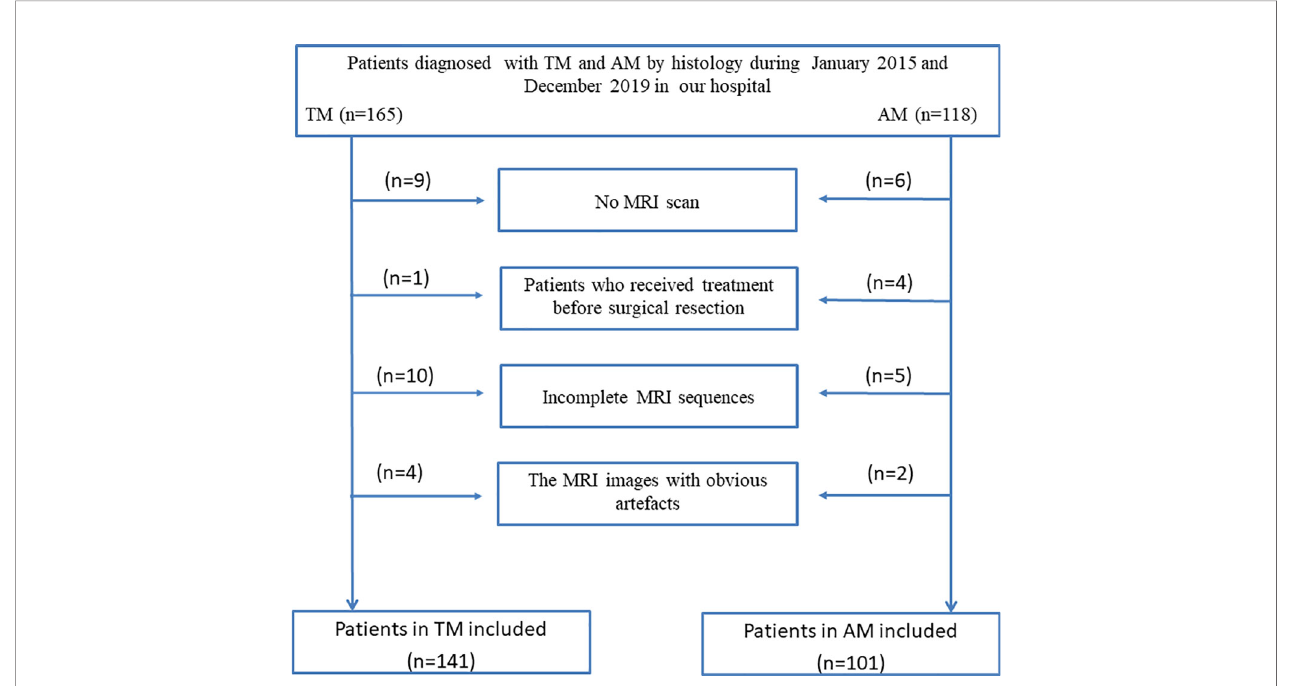
FIGURE 1 | Inclusion and exclusion